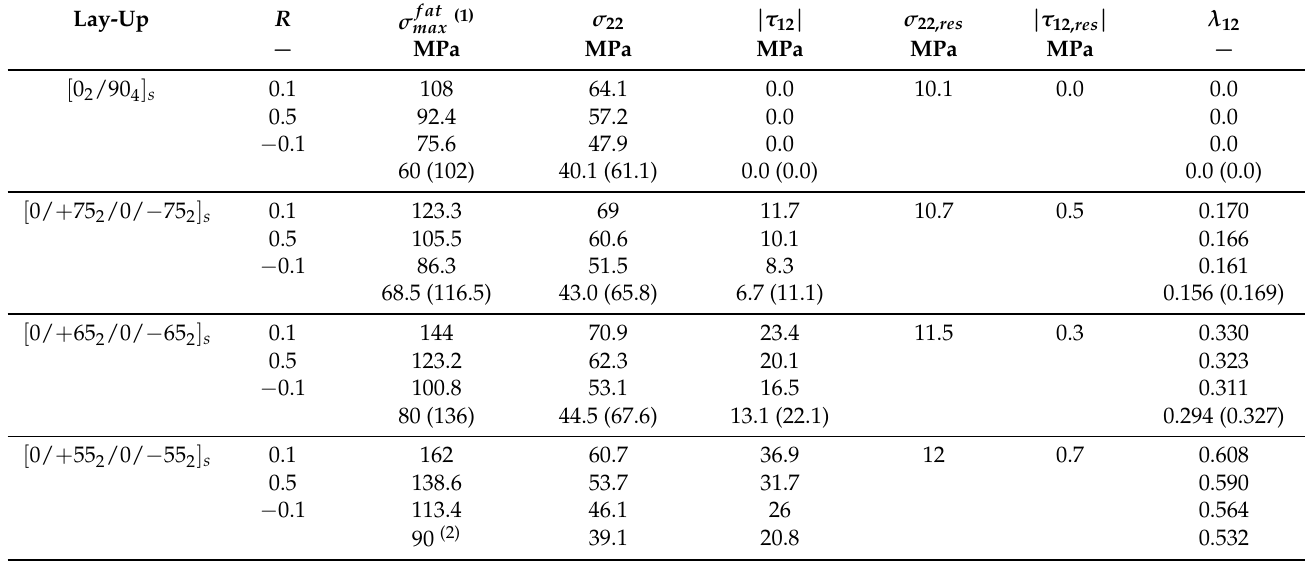
Table 3. Testing schedule and stress states of off-axis layers for fatigue